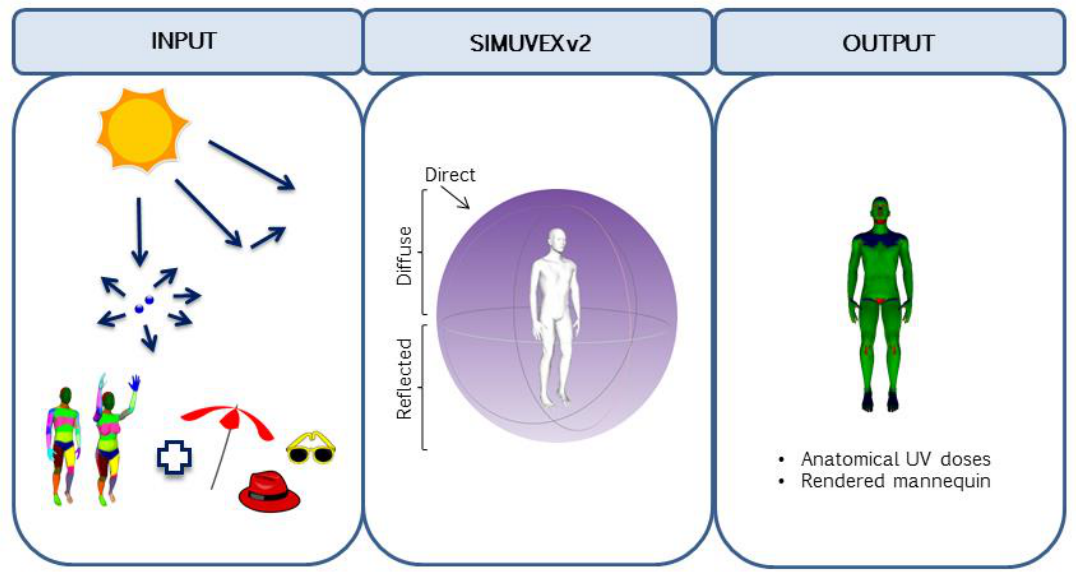
Figure 1. General overview of SimUVEx (Simulating UV Exposure). UV: ultraviolet.